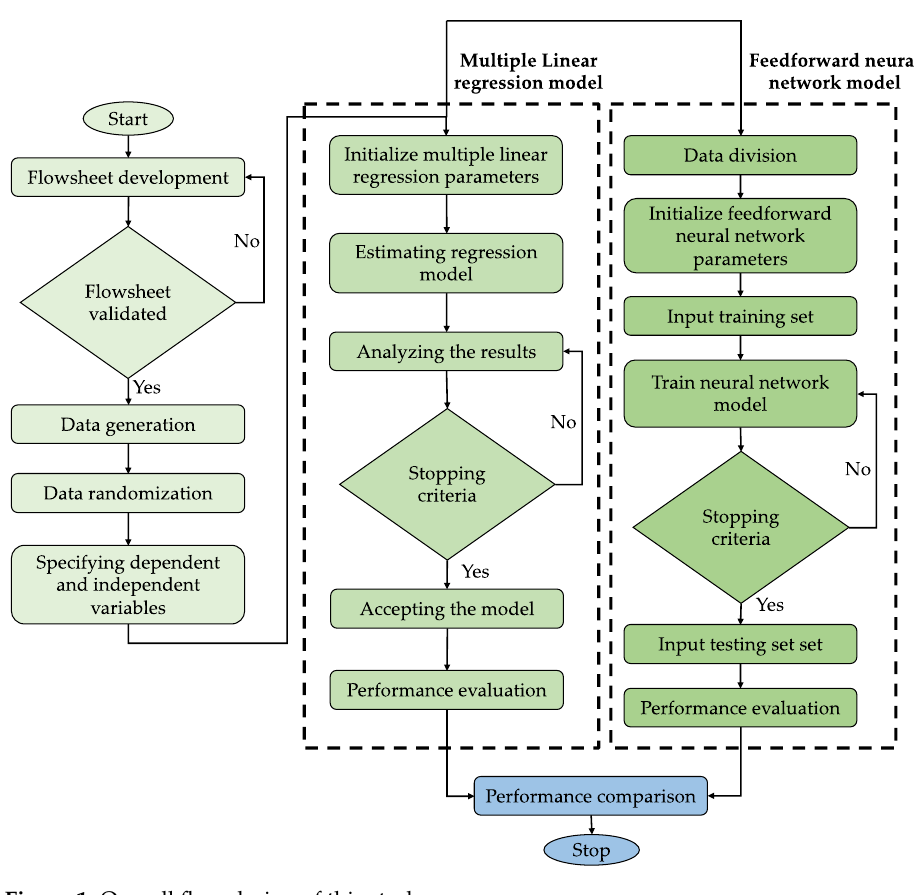
Figure 1. Overall flow design of this study.